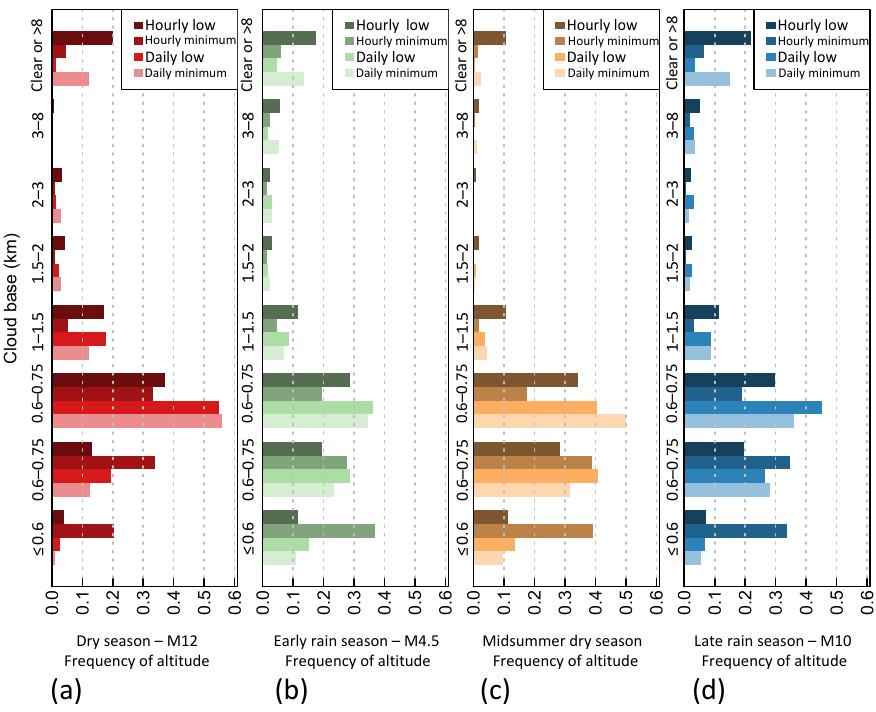
Figure 2. Frequency of low cloud base by season excluding non-representative months in each year from the Luquillo Experimental Forest ceilometer, May 2013 through August 2016: (a) dry season without the month of December (M12); (b) early rain season without 1–15 April (M4.5); (c) midsummer dry season; (d) late rain season without October (M10). The metrics are hourly low cloud base (first quartile, Q 1 , of each hour of 30s cloud base altitudes), hourly minimum value, daily low value (first tertile, T 1 , of the hourly low set), and daily minimum value (seventh octile, O 7 , of the hourly minimum